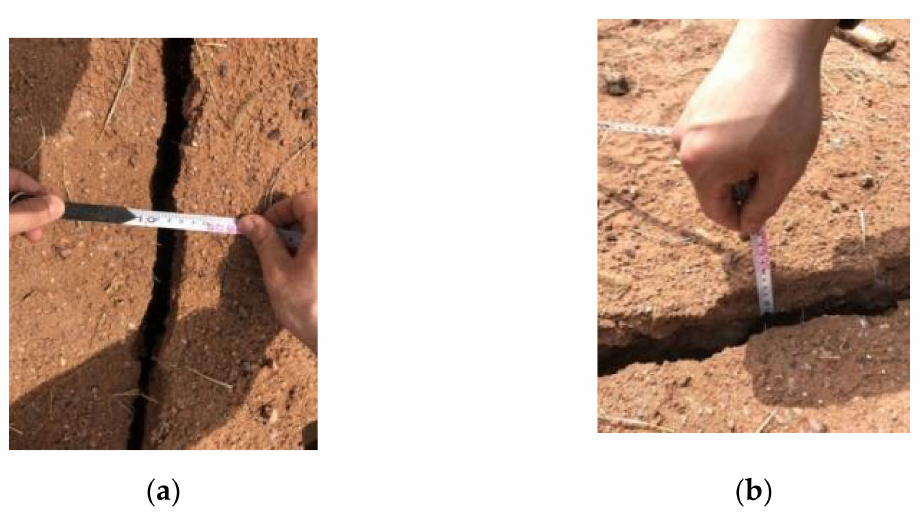
Figure 10. Surface crack drop and width measurement:( a ) Measurement of ground crack tension; ( b ) Ground crack step drop measurement.